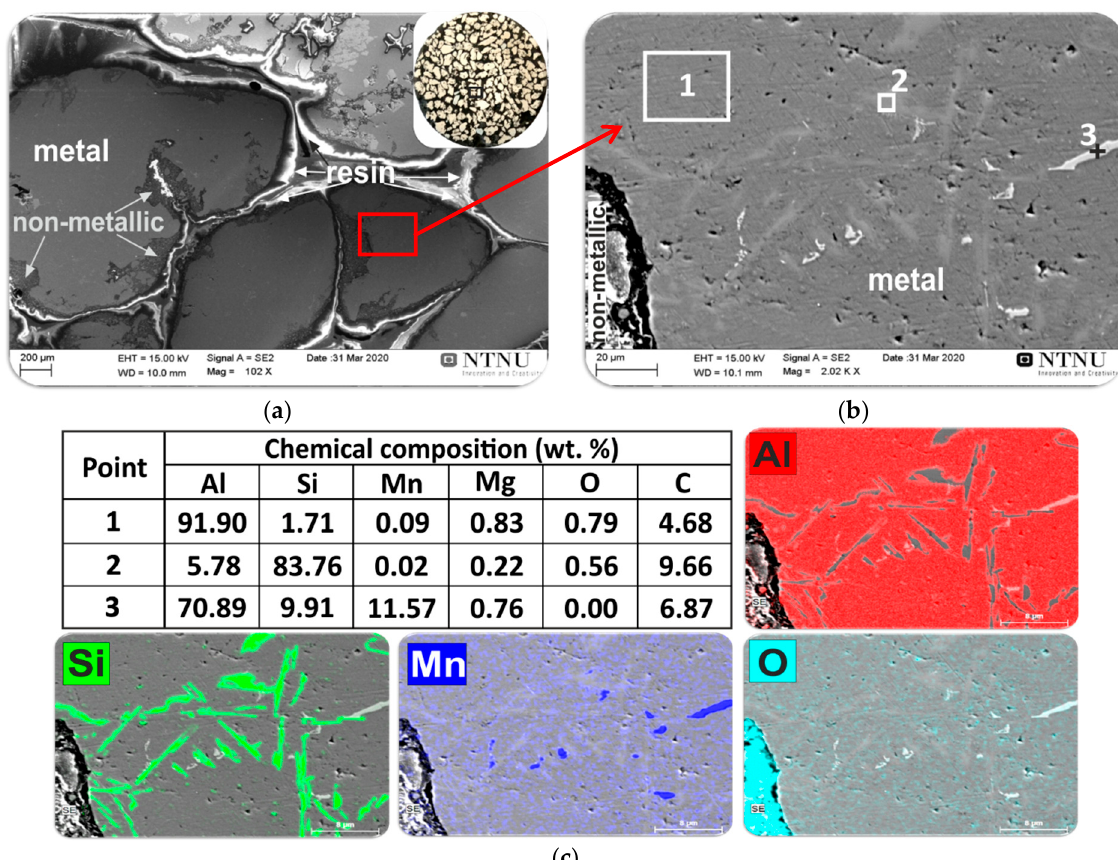
Figure 2. The SEM/EDS microstructural analysis results of particles of Al dross of size 1.25–2 mm used in the aluminothermic reduction: Scanning Electron Microscope - Backscattered Electrons images ( a , b ), EDS mapping ( c ).